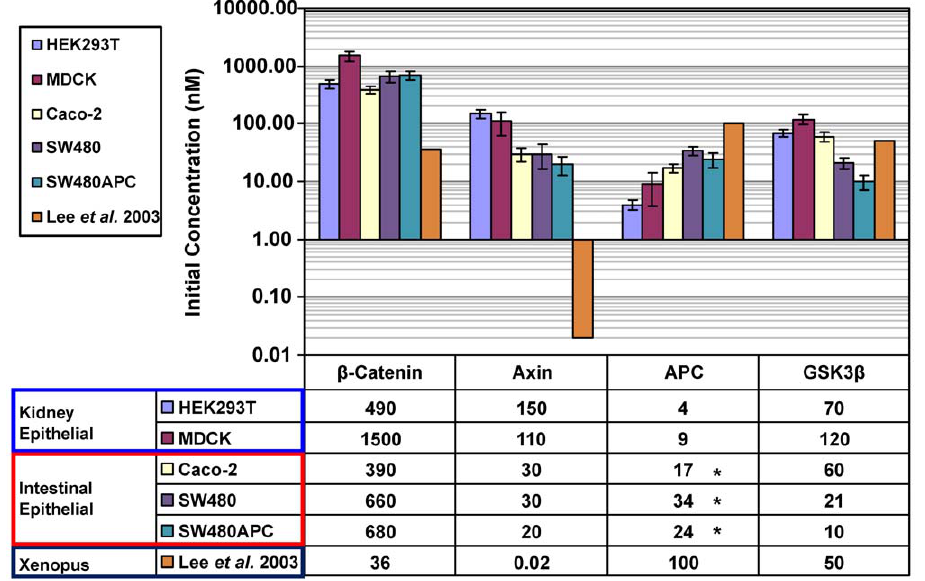
Figure 9. Key protein concentrations in different cell lines. Comparison of key protein concentrations ( b -catenin, Axin, APC and GSK3 b ) between the Xenopus extract (Lee et al ., 2003), two kidney epithelial mammalian cells (HEK293T and MDCK) and three intestinal epithelial mammalian cells (Caco-2, SW480 and SW480APC). * D APC measured in Caco-2, SW480 and SW480. For SW480APC, as the level of wild-type APC is too low to be detected in this set of experiment, the measurements made in this study comprised that of D APC only. The data is displayed in log scale.